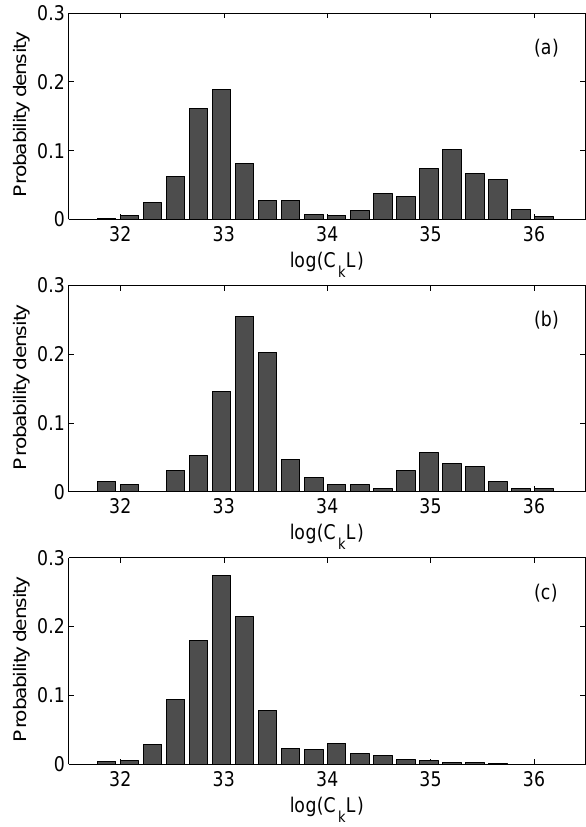
Fig. 14. C k L PDF from Pare Pare at dip = − 27 ◦ and t pss = 3 . 0h (a) and later at t pss = 5 . 0h (b) and t pss = 7 . 0h